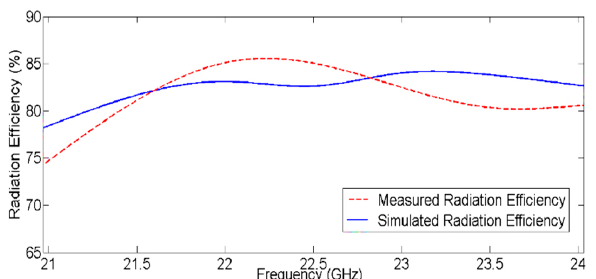
Figure 17. Far-field radiation pattern of H-plane SIW antenna array with three-way in-phase right- angled power divider at φ = 0 and θ between 0 and 360 degrees at ( a ) 22 GHz, ( b ) 22.5 GHz, and ( c ) 23 GHz.